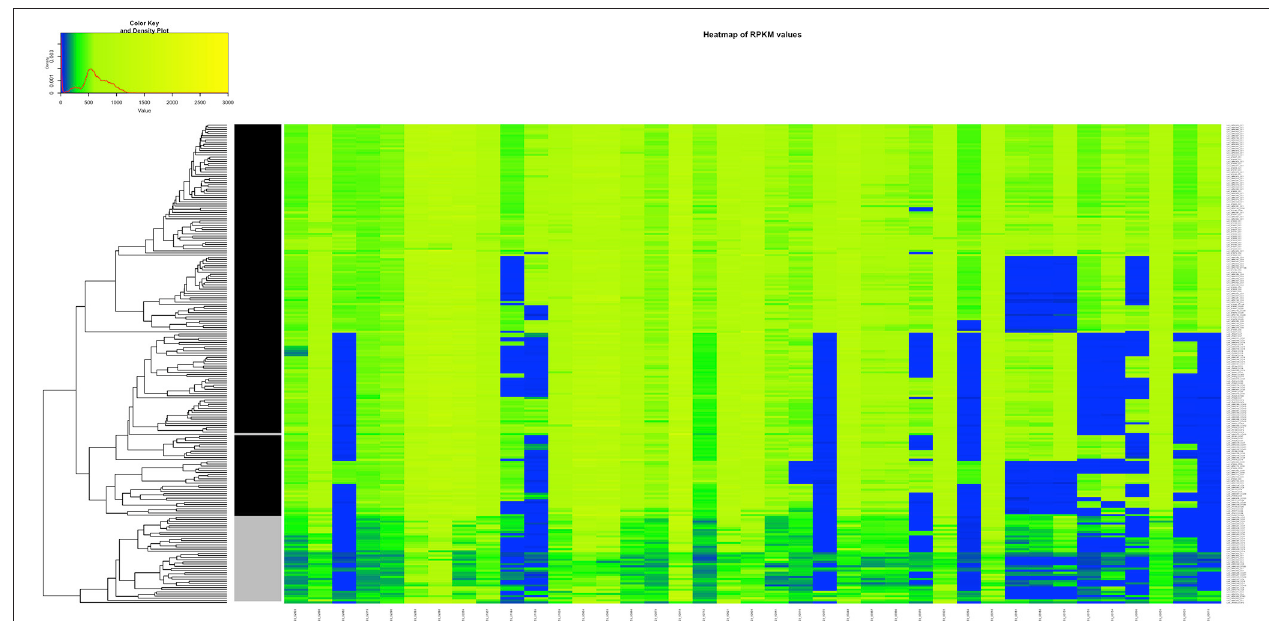
FIGURE 8 | Heatmap of the RPKM values per gene for the 39 selected genes in the 225 sequenced strains after the comparison between the clinical and non-clinical group. Gray scale color bar corresponds with the classification of the groups: black, clinical group; gray, non-clinical group; white, unclassified strain JF5593.